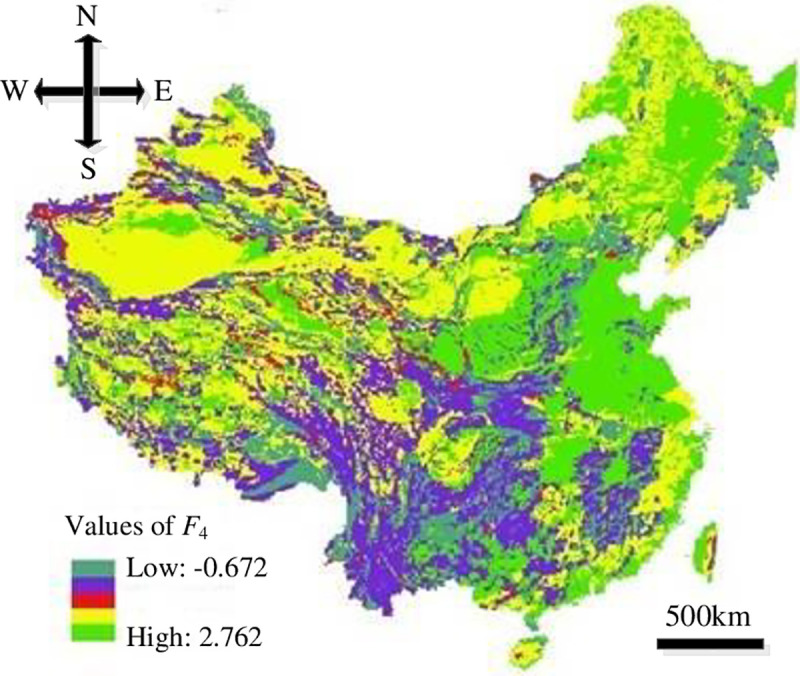
Distribution of F4.